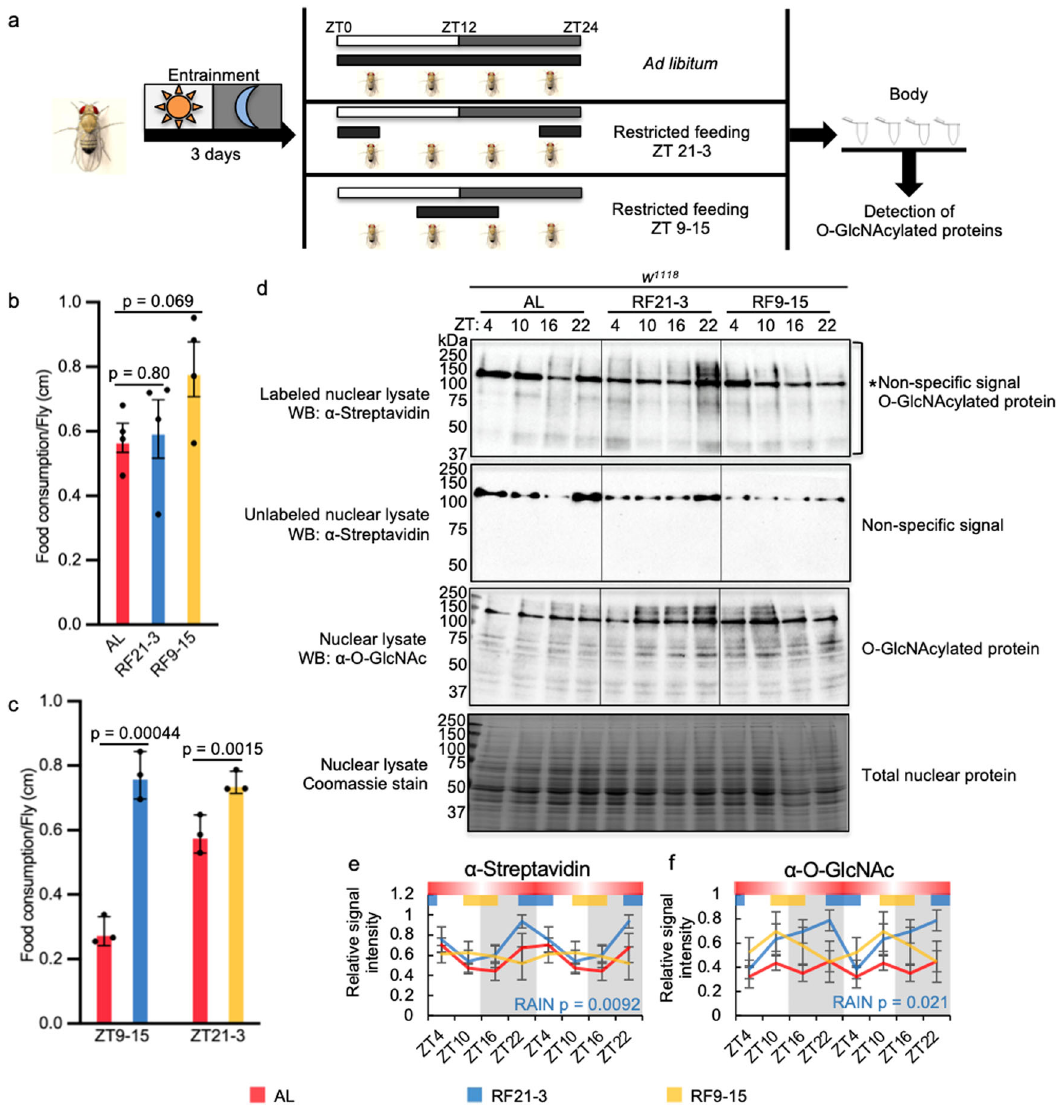
Fig. 3 Time-restricted feeding (TRF) at natural feeding time strengthens the rhythm of protein O-GlcNAcylation. a Schematic showing the study design. The black bars indicate the time when food was available. b Food consumption of AL, RF21-3 and RF9-15 groups over a 24-h period measured using CAFE assay ( n = 4, in comparison to AL group, RF21-3 p = 0.80 and RF9-15 p = 0.069, two-tailed Student ’ s t -test). c CAFE assay to compare food consumption of TRF groups to that of AL group during the indicated time window ( n = 3, in comparison to AL group, RF21-3 p = 0.0015 and RF9-15 p = 0.00044, two-tailed Student ’ s t-test). Data are presented as mean ± SEM. d Western blots showing daily rhythms in O-GlcNAcylation in fl ies fed AL, between ZT21-3, or ZT9-15. O-GlcNAcylation was detected using two methods: (top 2 panels) chemoenzymatic labeling in combination with immunoblotting with α -streptavidin and (third panel) immunoblotting with α -O-GlcNAc. Unlabeled samples (second panel) were processed in parallel to labeled samples (top panel) to identify non-speci fi c signal. Total nuclear proteins stained by Coomassie blue (bottom) were used for normalization. The asterisk (top panel) indicates non-speci fi c signal. Each biological replicate was performed independently with similar results ( n = 4). e , f Quanti fi cation of protein O-GlcNAcylation detected using enzymatic labeling ( n = 4; AL: p = 0.045, RF21-3: p = 0.0092, RF9-15: p = 0.83, RAIN; AL vs RF21-3: mesor p = 0.05, amplitude p = 0.62, phase p = 0.3, CircaCompare) and α -O-GlcNAc immunoblotting ( n = 4; AL: p = 0.83, RF21-3: p = 0.021, RF9-15: p = 0.69; RAIN). Gray shading indicates the dark period of LD cycle. Colored bars at the top of graphs denote the feeding periods for TRF treatment groups, RF21-3 (blue) and RF9-15 (yellow). The red bars with gradient shading illustrate the representative feeding pattern for AL fl ies (data depicted from Fig. 2a), and the darker area indicates higher feeding activity. Data are double plotted, normalized (peak = 1), and presented as mean ± SEM. The biological replicates of AL group that are quanti fi ed in ( e ) are the same four replicates quanti fi ed in Fig. 1b. In ( d ), a different biological replicate of AL group, other than the one shown in Fig. 1a, was ran together on the same gel with RF21-3 and RF9-15